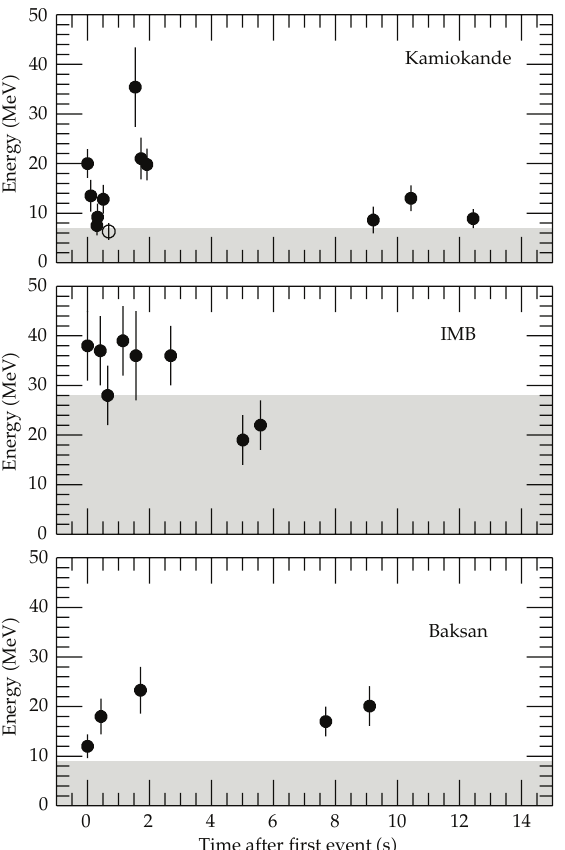
Figure 6: SN1987A neutrino observations at the neutrino detectors Kamiokande II [40], IMB [41], and at Baksan [42]. The energies refer to the secondary positrons from the reaction 𝜈 𝑒 + 𝑝 → 𝑛 + 𝑒 + . In the shaded area, the trigger efficiency is less than 30%. The clocks of the various experiments had unknown relative offsets. Therefore, for each detector spectrum, the time was calibrated such, that the first event was recorded at 𝑡 = 0 . In Kamiokande II, the event marked as an open circle is attributed to background (reprinted with permission